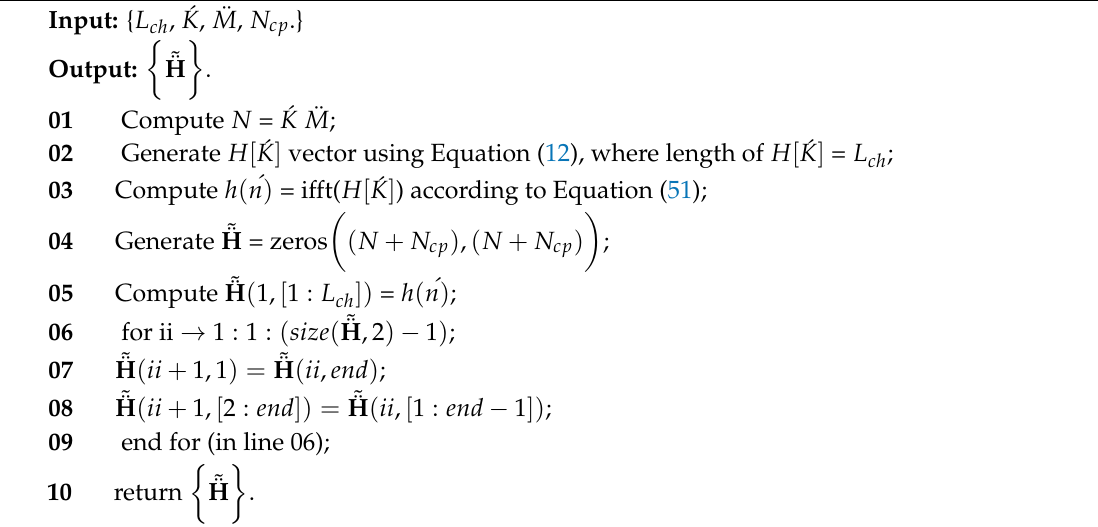
Algorithm 1: Sequential procedure for realising the GFDM-OQAM